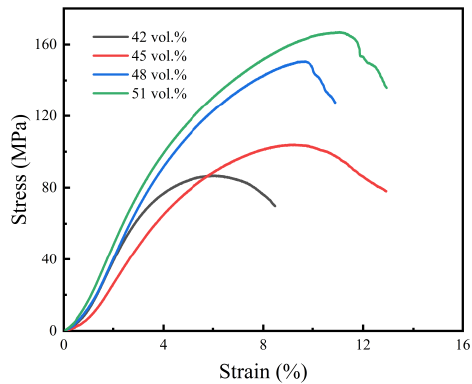
Figure 11. Stress–strain curves of sintered bodies. Figure 11. Stress – strain curves of sintered bodies.